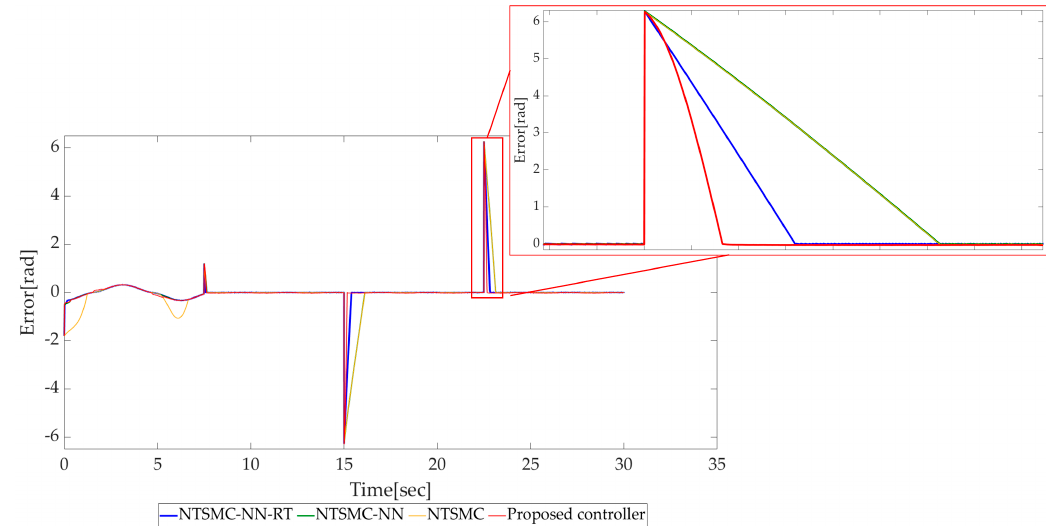
Figure 23. Comparing 𝜃 (cid:2870) error for mixed input.